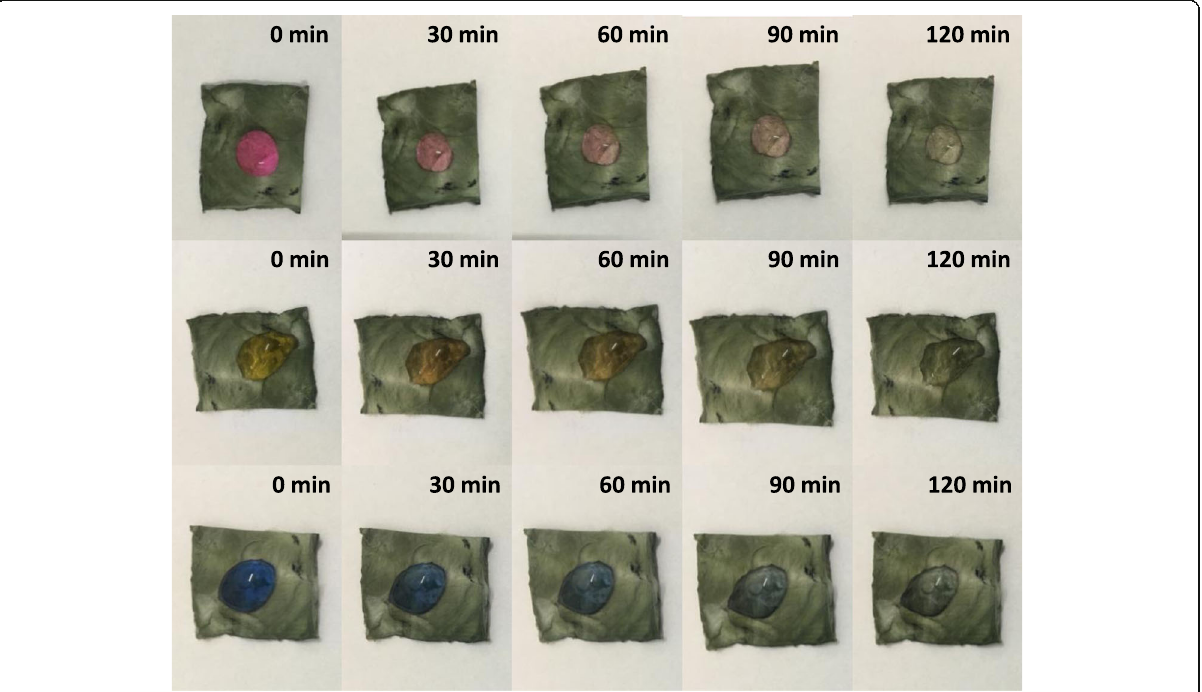
Fig. 10 The optical photograph of the RhB, MO, and MB droplet on the surface of Cu 1 under visible light